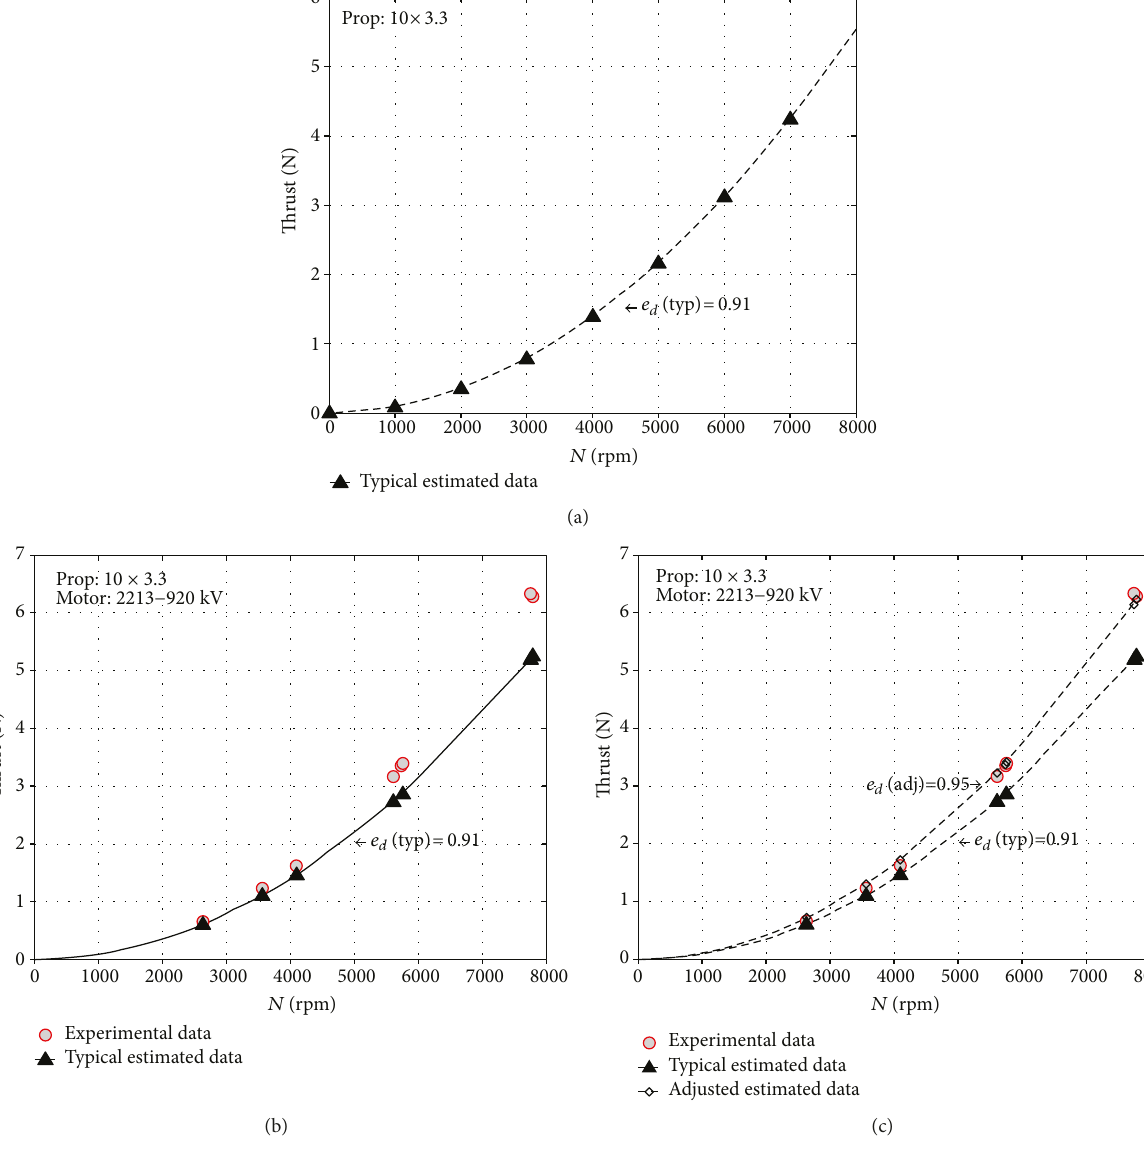
Figure 9: Fine tuning of the model based on the experimental